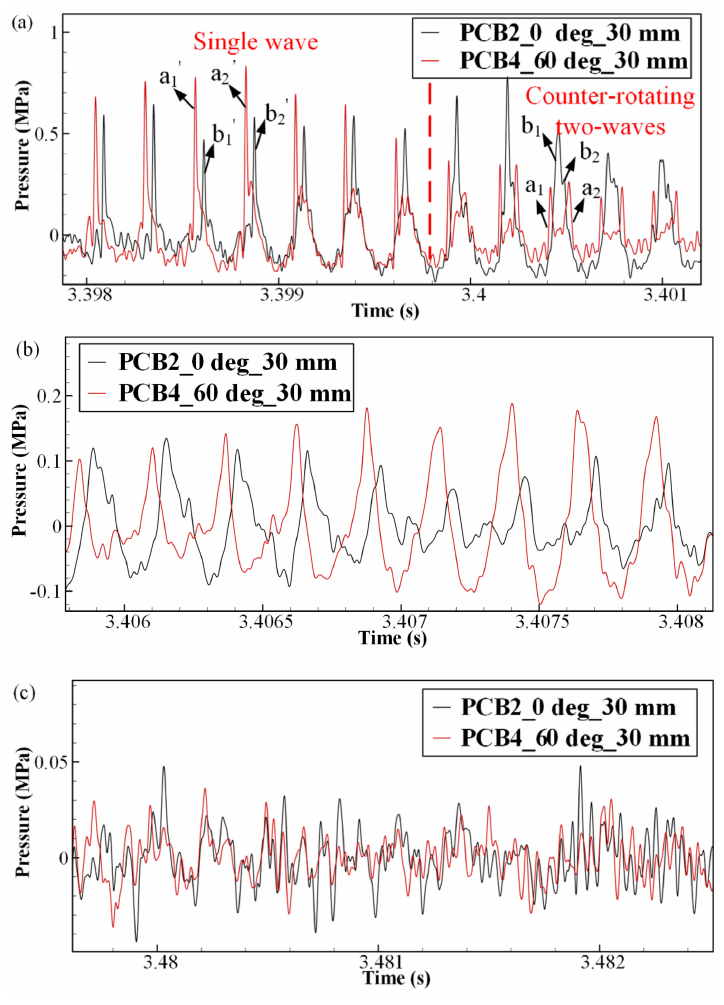
Figure 5. Local view of dynamic high-frequency pressure for three different combustion modes: ( a ) hybrid mode (Case #1); ( b ) sawtooth wave mode (Case #2); and ( c ) deflagration mode (Case